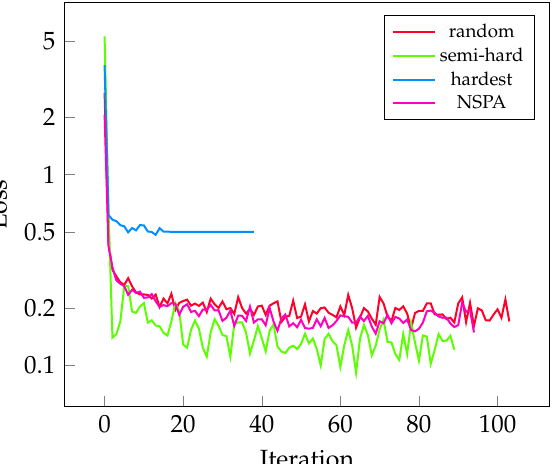
Figure 5. The improvement of the measured validation loss during training for different sampling methods. Each were tested in 5–5 training rounds; the best-performing models are selected